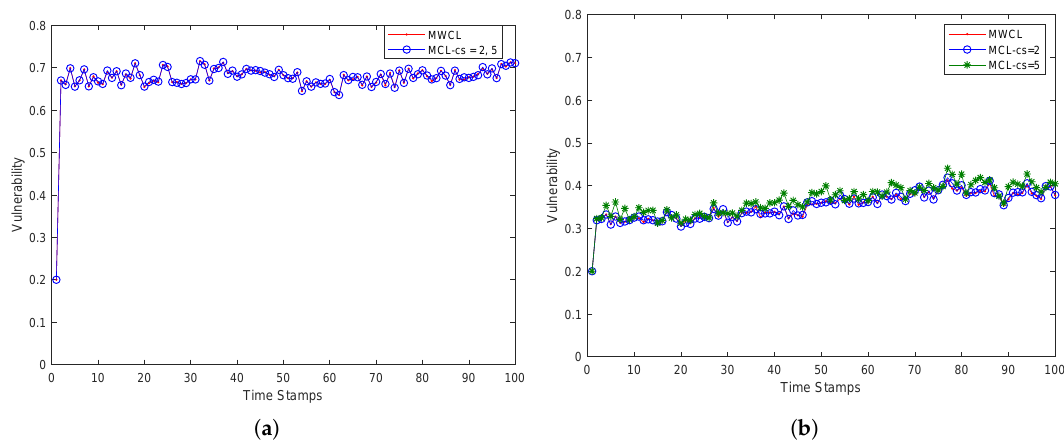
Figure 4. Both clustering and k -NN: ( a ) x and ( b ) ( x , y ) for N = 400 trajectories, L = 100 time-stamps and k = 5.